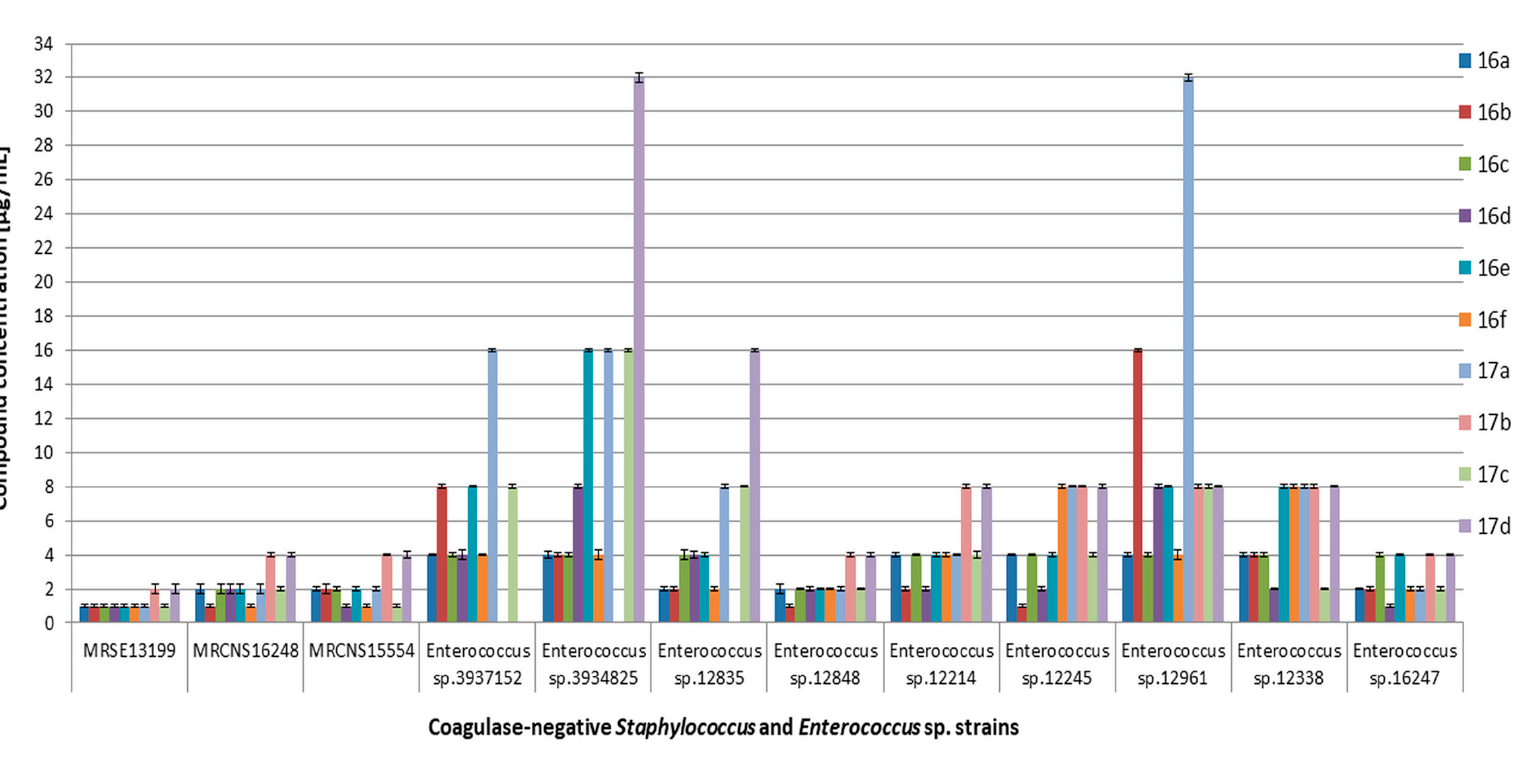
Figure 3. Minimum inhibitory concentration (MIC) [µg/mL] of the compounds on clinical bacterial strains MRCNS and Enterococcus sp.